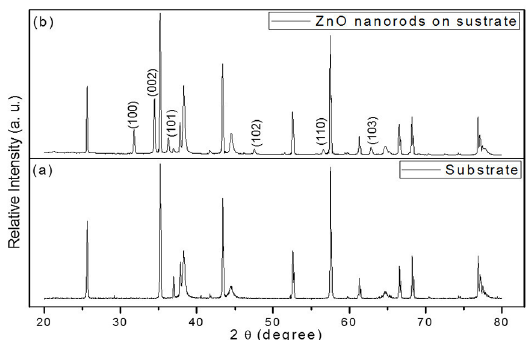
Figure 2. X-ray diffraction patterns of (a) bare sensor substrate and (b) ZnO nanorods on the substrate after chemical bath deposition